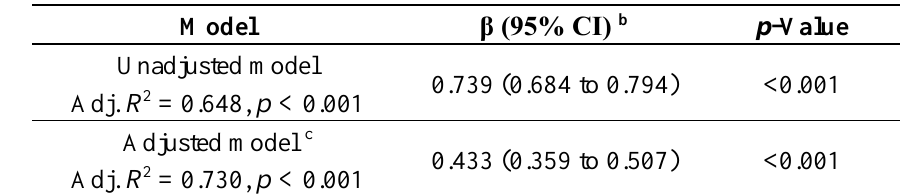
Table 4. Multiple regression analysis of associations between dietary iron and zinc intakes in women aged 18–50 years ( N = 379) a